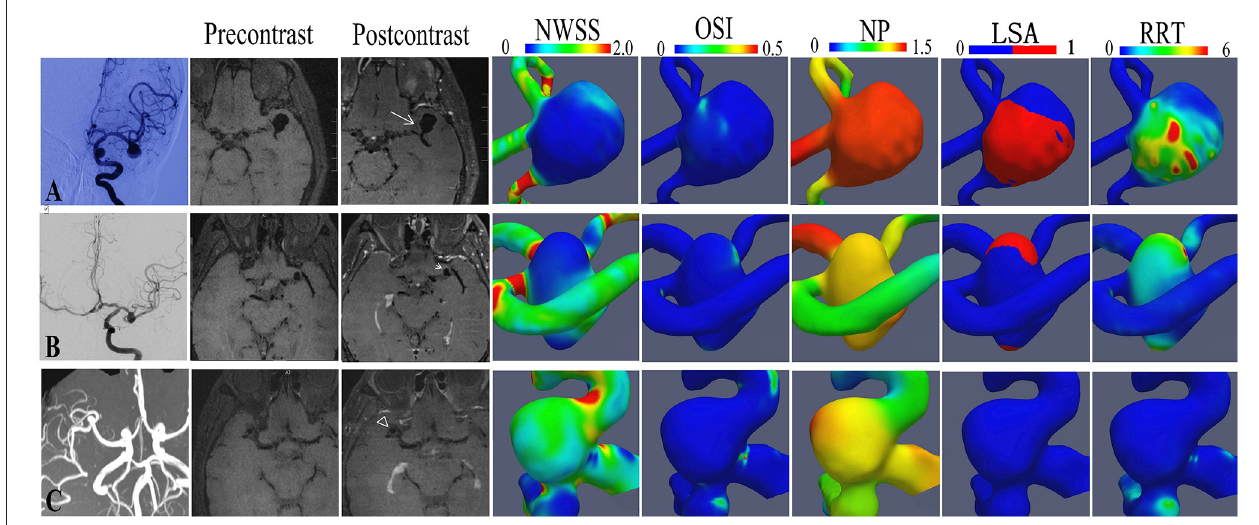
FIGURE 1 | The hemodynamic features of representative aneurysms with different aneurysm wall enhancement patterns. A bifurcation aneurysm of the middle cerebral artery (MCA) with circumferential wall enhancement (A) , a bifurcation aneurysm of the middle cerebral artery (MCA) with partial wall enhancement (B) , and a bifurcation aneurysm of the MCA without enhancement (C) .